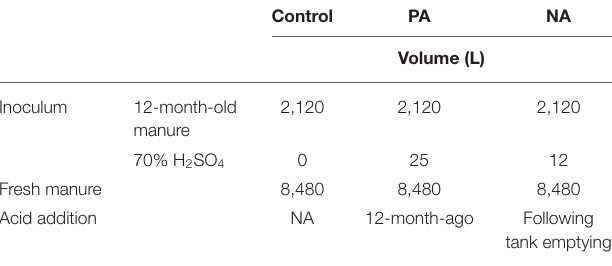
TABLE 1 | Volume (L) of 70% sulfuric acid (H 2 SO 4 ), inoculum, and manure added to the control, previously acidified inoculum treatment (PA), and newly acidified inoculum treatment